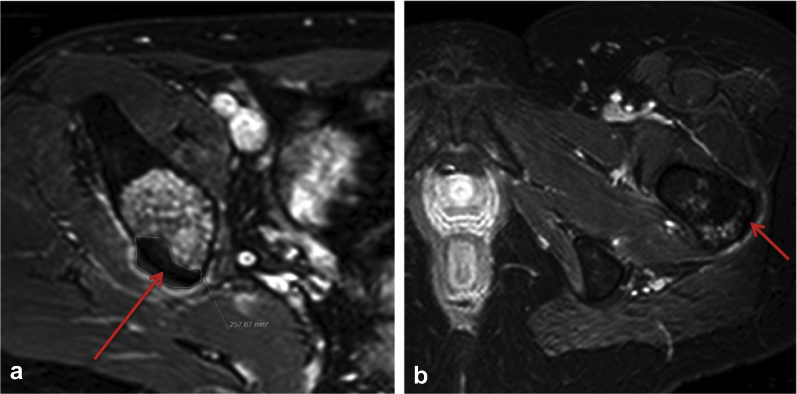
Example of a gadolinium-enhanced T1-weighted (Gd-T1W) image at 30 days after treatment. A clear focal region of nonenhancement (red arrows) was seen on either side of the bony cortex for intraosseous tumors (a) in a 36-year-old male with metastatic lung cancer, and (b) in a 45-year-old female with metastatic breast cancer. In both cases, a thin rim of enhancing tissue is also seen at the proximal border of the region of nonenhancement.